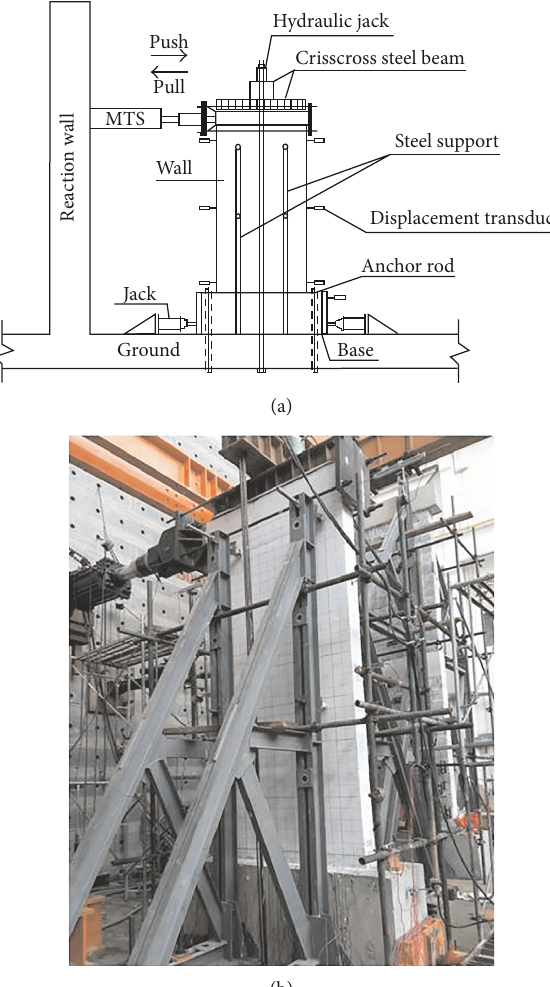
Figure 12: Test setup: (a) schematic and (b) photograph.